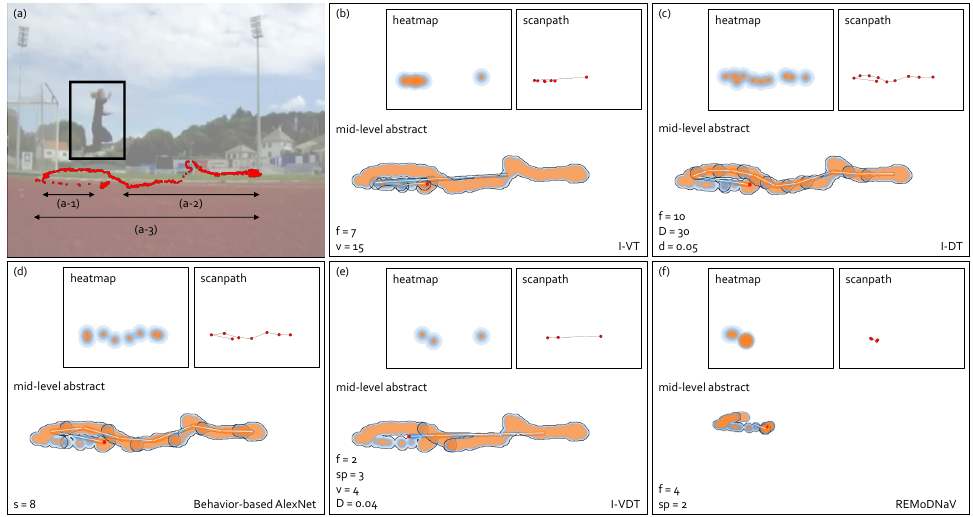
Figure 13. Comparison of gaze data visualizations for various gaze-parsing algorithms using Lund2013 dataset [15]. ( a ) The visual stimulus, moving target in the black box, and raw gaze points in red. ( a-1-a-3 ) indicate the gaze data segments. ( b – d ) The results obtained using I-VT, I-DT, and our behavior-based AlexNet, respectively. ( e ) and ( f ) The results of identifying eye movement events with I-VDT and REMoDNaV, respectively. The results of each algorithm are represented in the heatmap, scanpath, and mid-level abstract gaze movement visualizations. The parameter settings and the number of detected eye movement events are disclosed in each subplot.